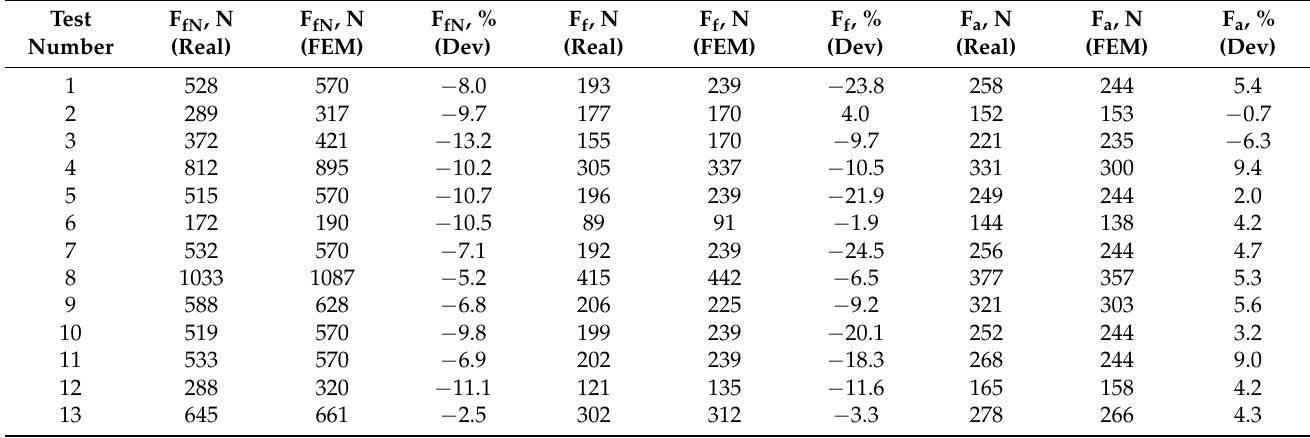
Table 3. Cutting force